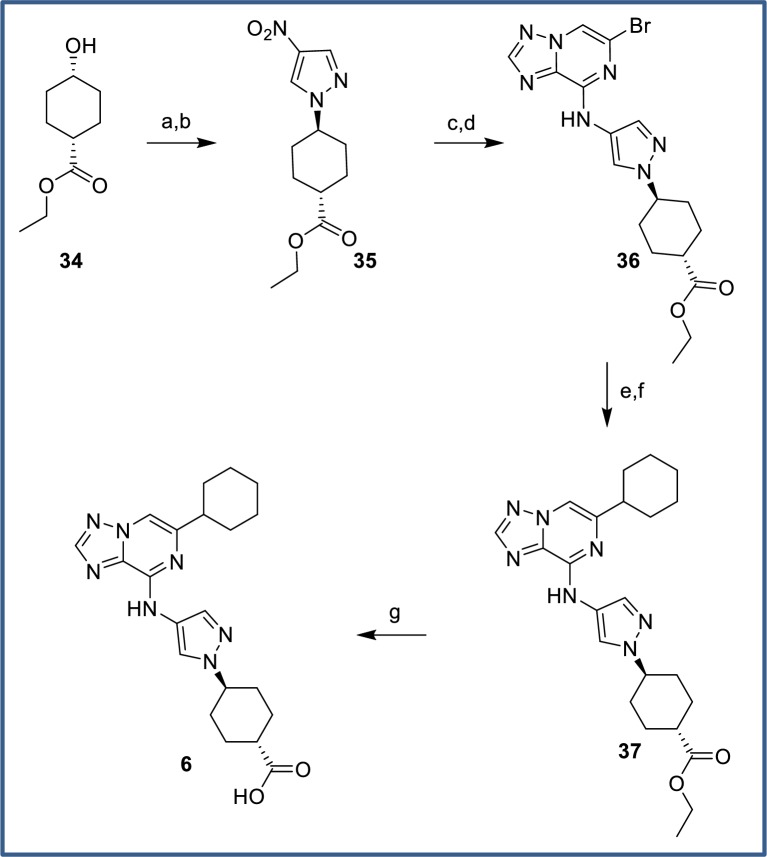
Synthesis of carboxylic acid 6.Reagents and conditions: (a) TsCl, pyridine, 0°C to rt, 80%; (b) 4-nitropyrazole, Cs2CO3, DMF, 77%; (c) 10% Pd/C, H2 (1 atm), THF/EtOH, rt, 93%; (d) 24, Et3N, DMF, rt, 97%; (e) cyclohex-1-en-1-ylboronic acid, Pd(PPh3)2Cl2, Cs2CO3, 1,4-dioxane/water, 90°C, 89%; (f) Pd(OH)2, H2 (1 atm), MeOH/THF, rt, 87%; (g) NaOH, MeOH/H2O, rt, 96%.